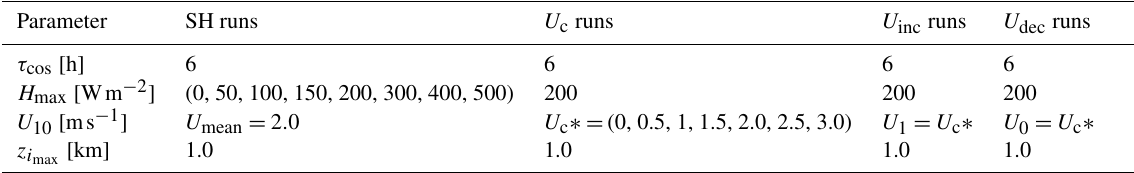
Table 3. Simulation settings for model experiment test